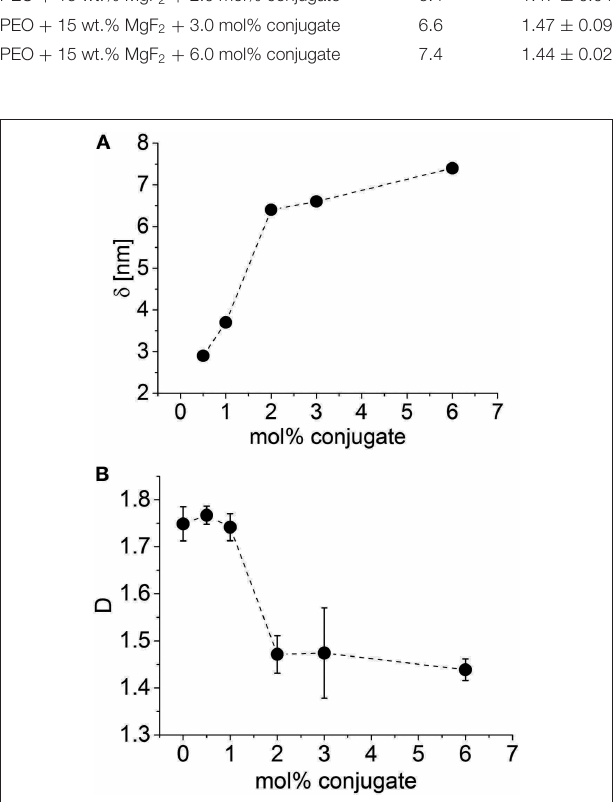
FIGURE 2 | Dependency of (A) true layer thickness δ and (B) fractal dimension D on amount of added conjugate in the composition. Both curves show strong changes between 1.0 and 2.0 mol%